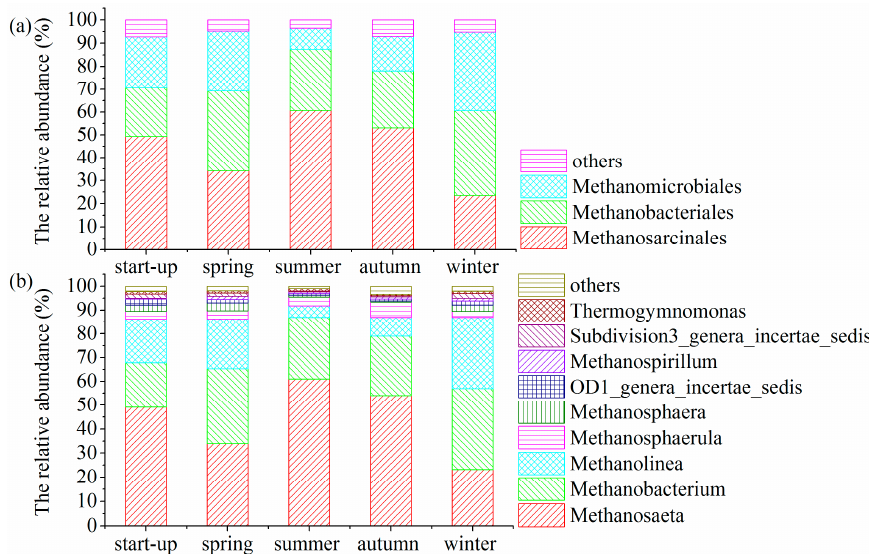
Figure 8. Archaeal community shifts at ( a ) order and ( b ) genus level.